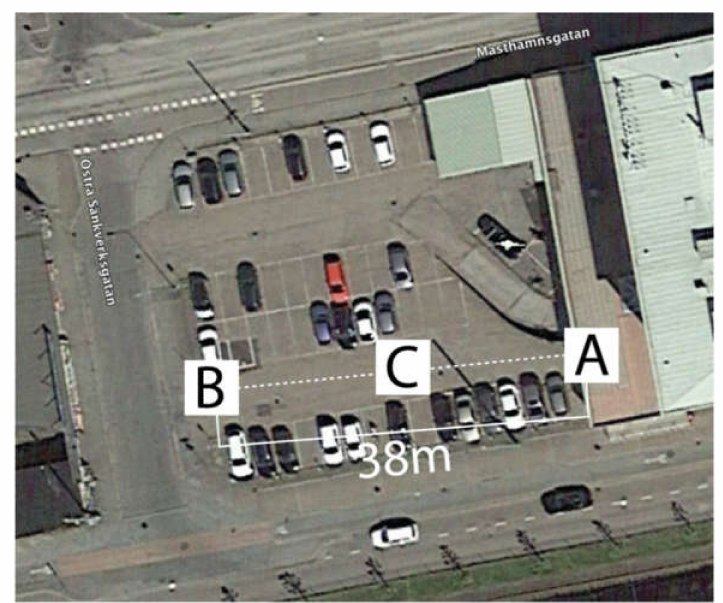
Figure 5. Placement of markers on-site for P7, markers were 1.8 m × 1.8 m ( A ), and ( B , C ) 0.9 m × 0.9 m in size.